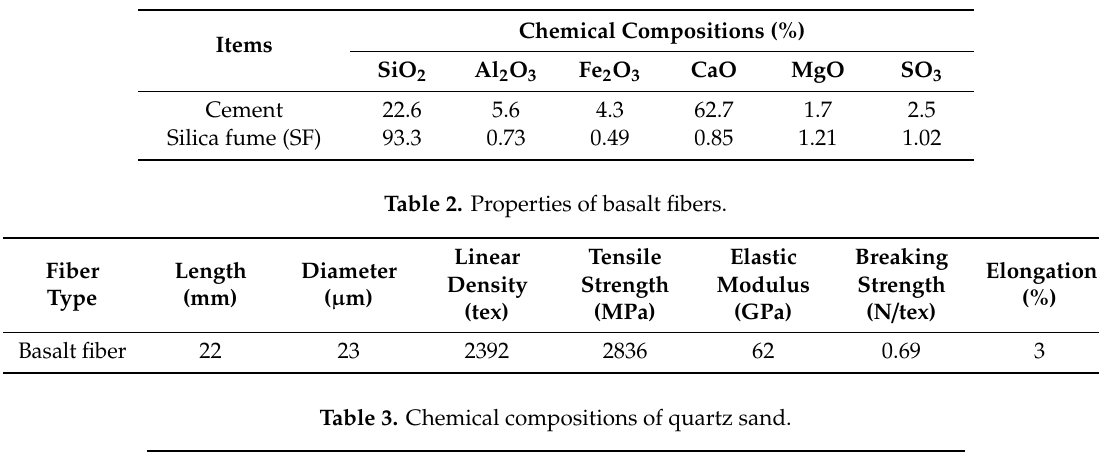
Table 1. Chemical compositions of cement and silica fume.